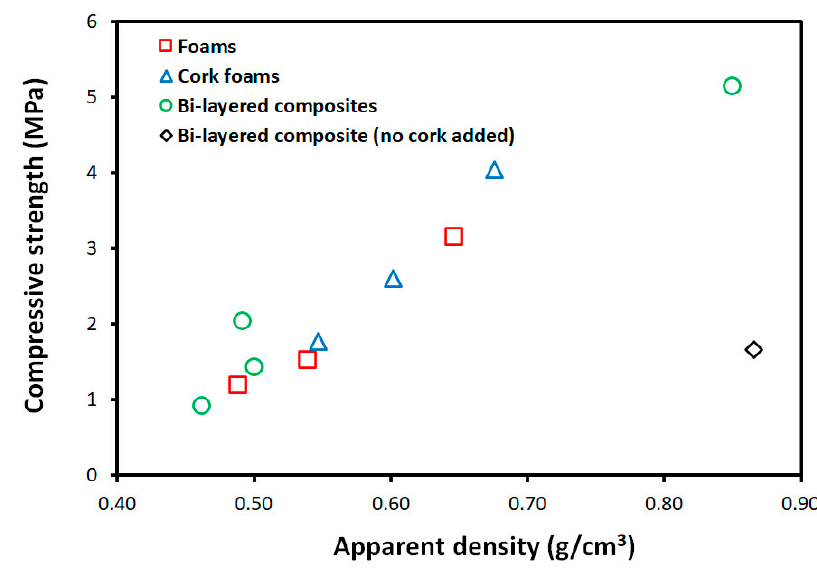
Figure 9. Correlation between the density and compressive strength in the lightweight inorganic polymers.